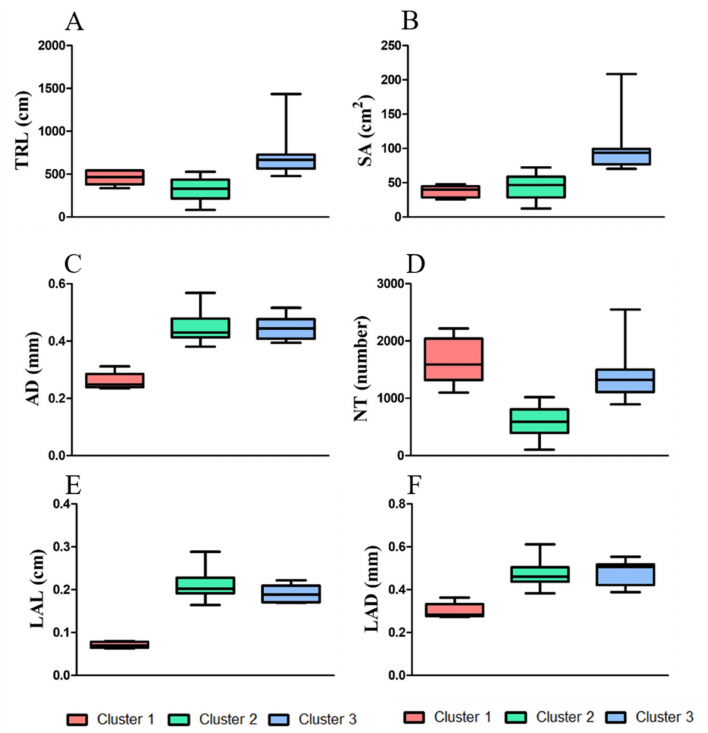
Figure 4. Box plots displaying the measured root traits for individual clusters, and according to the number of accessions belonging to each cluster. The central value and variability of the 61 accessions are based on the three clustering groups obtained from K-means cluster analysis. The six root traits were plotted as follows: ( A ) TRL, total root length; ( B ) SA, surface area; ( C ) AD, average diameter;